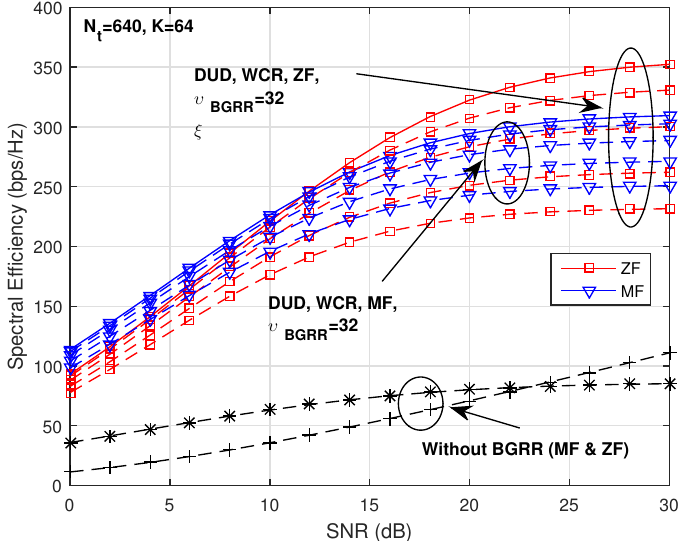
Figure 14. SE (bps/Hz) versus SNR (dB), when N t = 640, K = 64, χ DM − RS = 10, υ BGRR = 32, ξ = 1,0.98,0.95,0.90,0.85. Red lines are the ZF precoding and blue lines are the MF precoding.